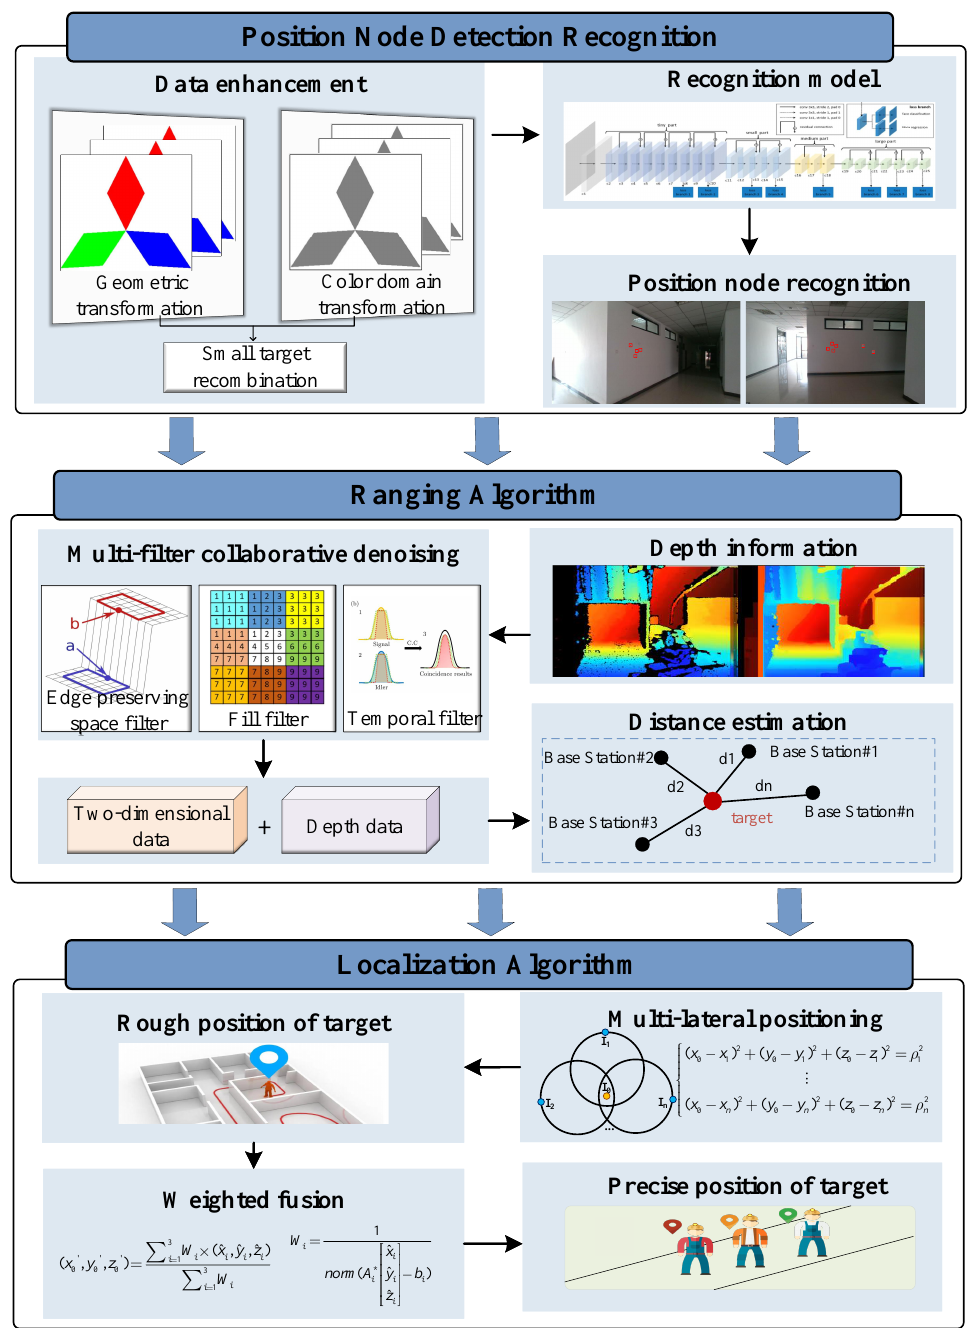
Figure 2. System